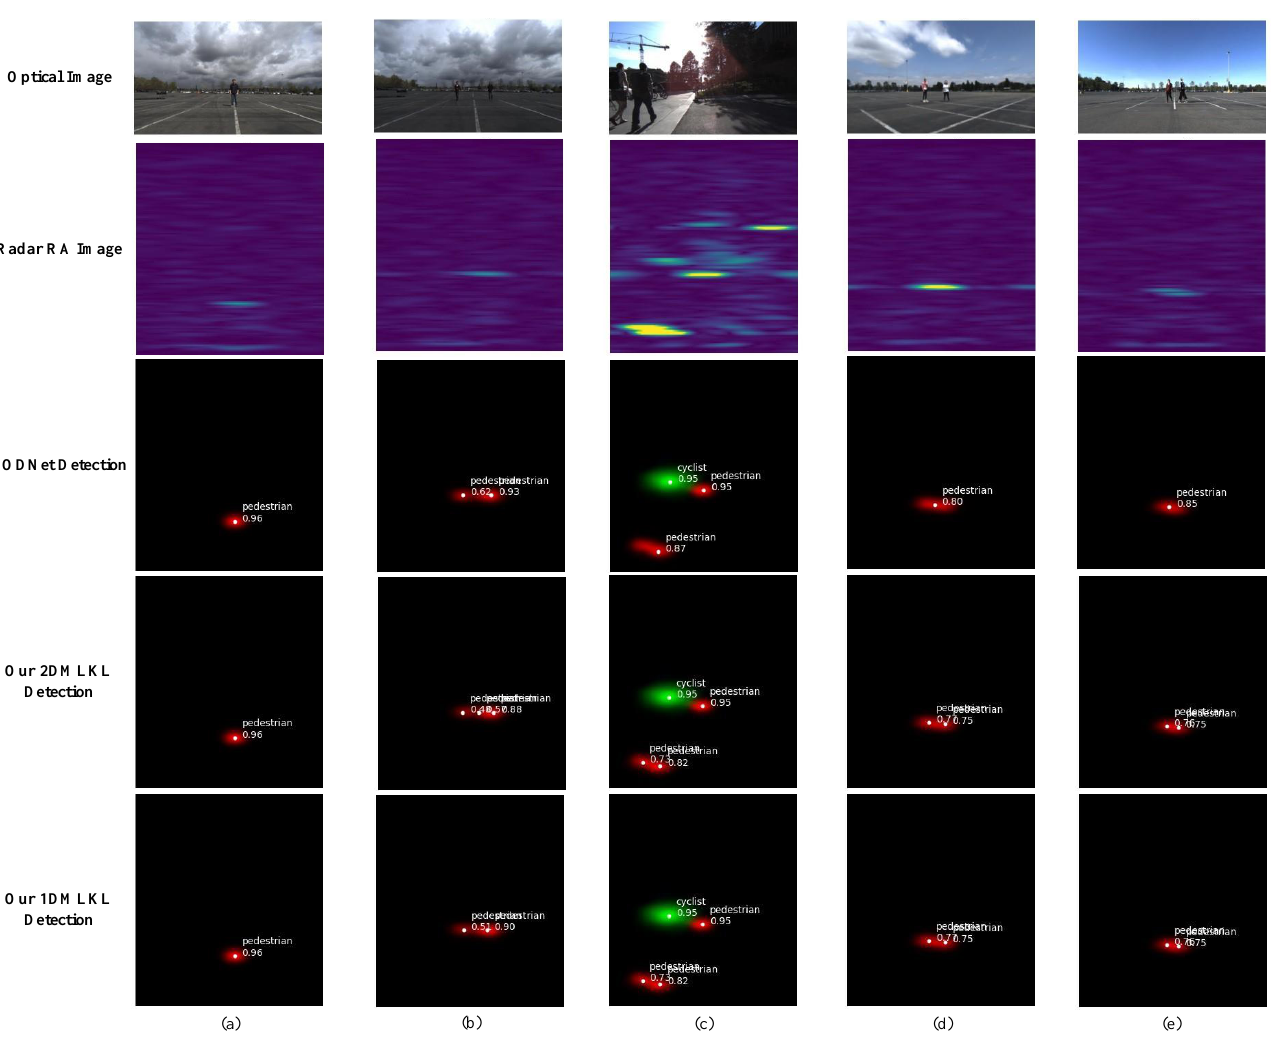
Figure 18. Comparison of experimental results, where ( a ) corresponds to Case (1), ( b ) corresponds to Case (2), ( c ) corresponds to Case (3), and ( d ) and ( e ) correspond to Case (4).